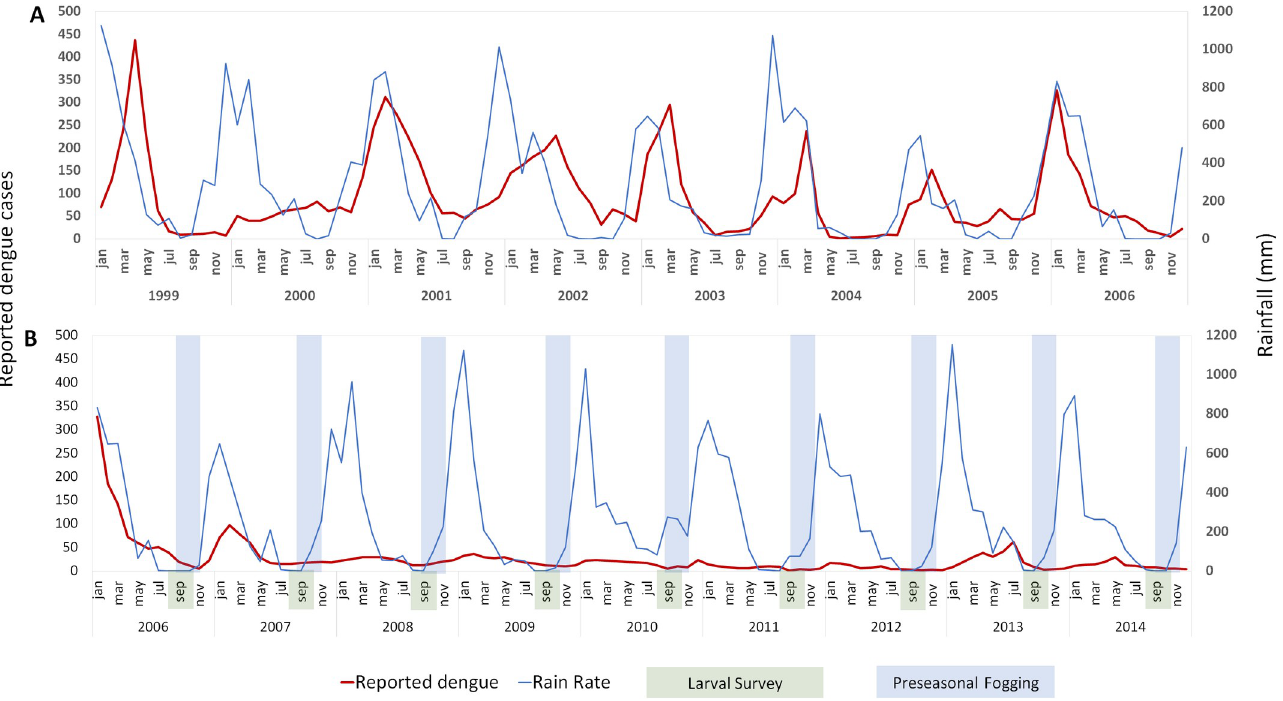
Fig 1. Relationship between rainfall and cases of Dengue as reported by the Ministry of Health (MoH) of Makassar City. ( A ) A slight lag seen in increased Dengue cases and the onset of rainfall during the transmission season every year before the intervention. (B) After implementation of the revised program of larval surveys followed by fogging in selected areas based on HI, an immediate and sustained decrease is seen in dengue cases for 8 years. Green boxes denote the period of larval surveys, while the blue boxes depict the period of the additional pre-emptive, dry-season fogging, Note that rainfall does not significantly change pre and post